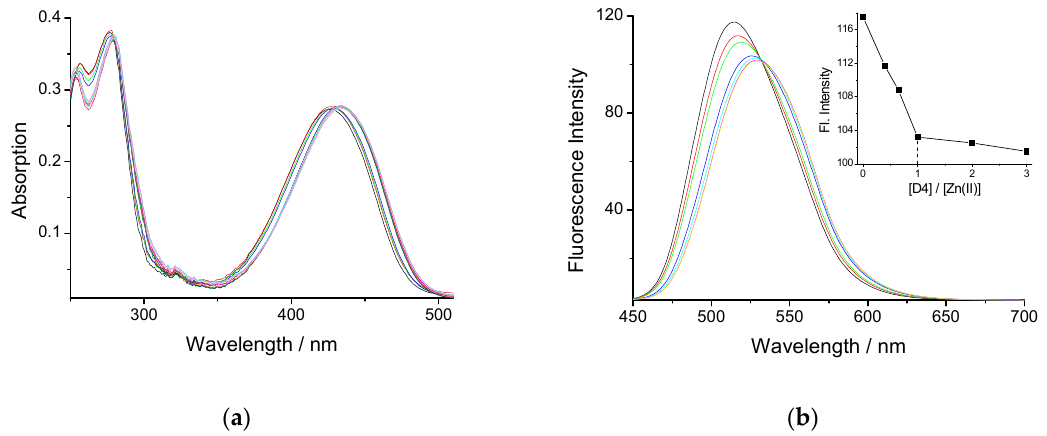
Figure 1. The absorption ( a ) and fluorescence ( b ) spectra of dendrimer D4 (c = 2 × 10 − 5 mol/l in the presence of Zn(II) (c = 0 ÷ 6 × 10 − 5 mol/l).